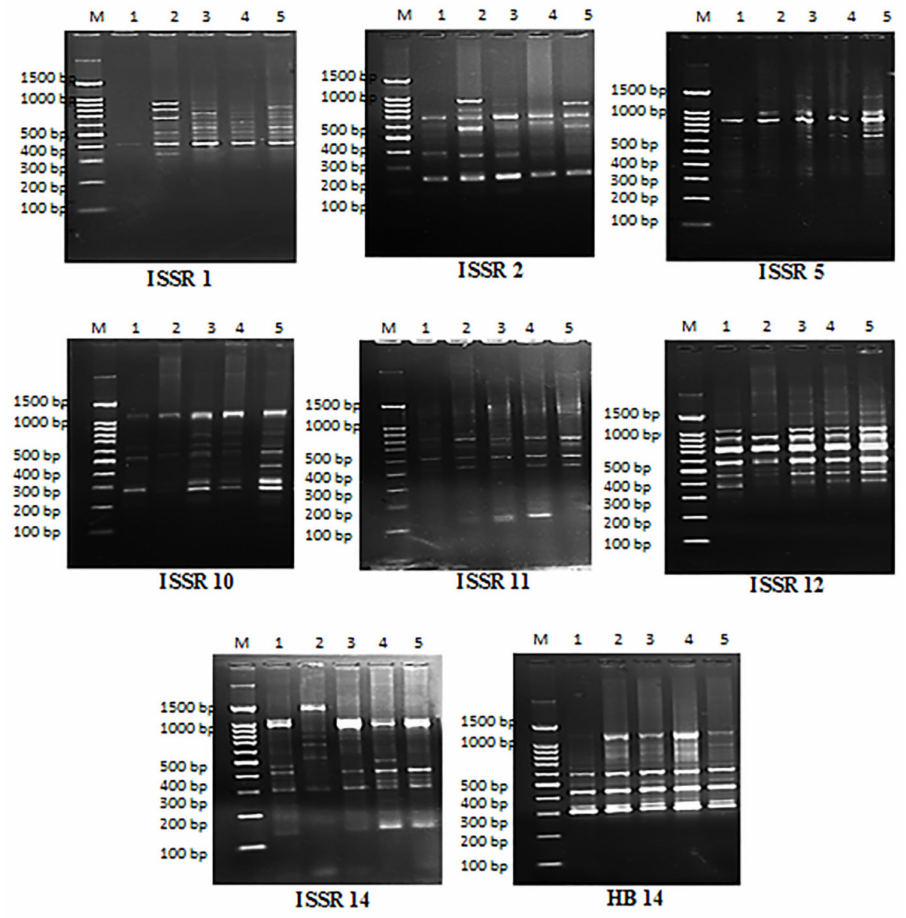
Figure 12. Banding profiles of ISSR for treated Vicia faba seeds with C. acutum latex and its different concentrations from Cy-AgNPs. M: Marker, 1: control, 2: Crude latex extract (3%), 3: Cy-AgNPs